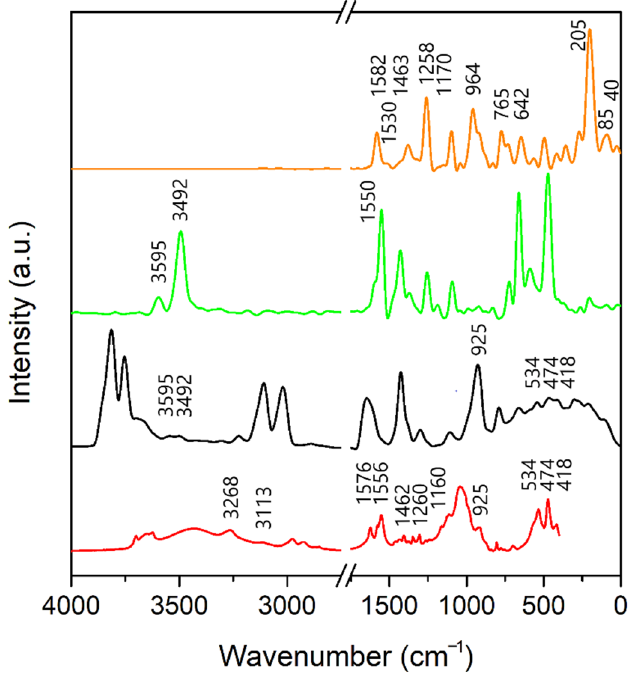
Figure 8. The experimental (red) and total VDOS (black), the projected VDOS of the NH groups (green) and the projected VDOS of the triazine ring (orange) for the A-TMP-Bd model.